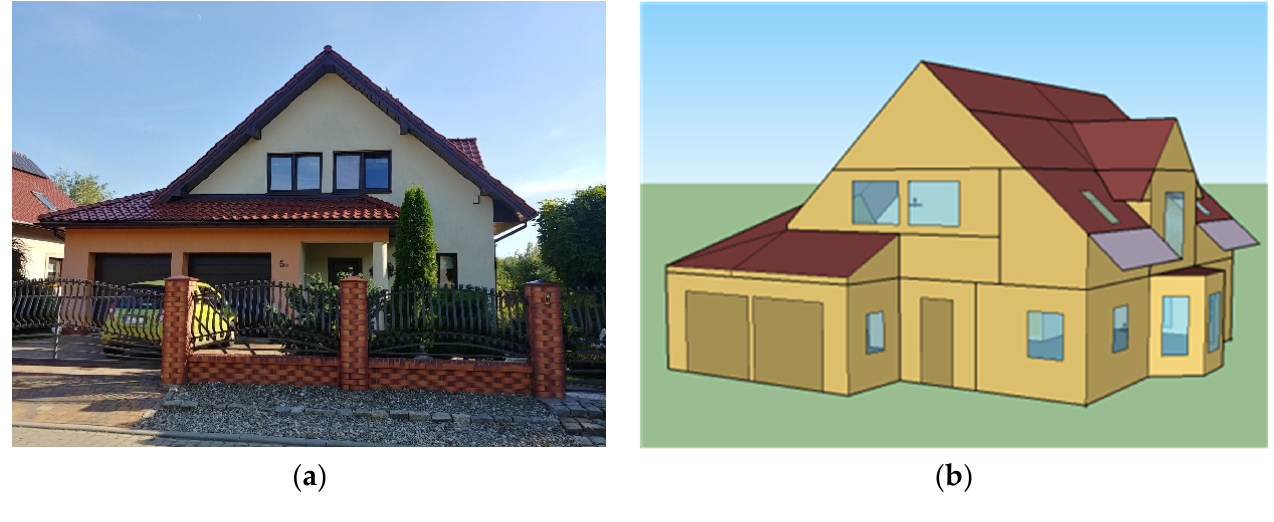
Figure 1. ( a ) Real building view; ( b ) model view. Table 1. Building construction with the value of the heat transfer coefficient. Building